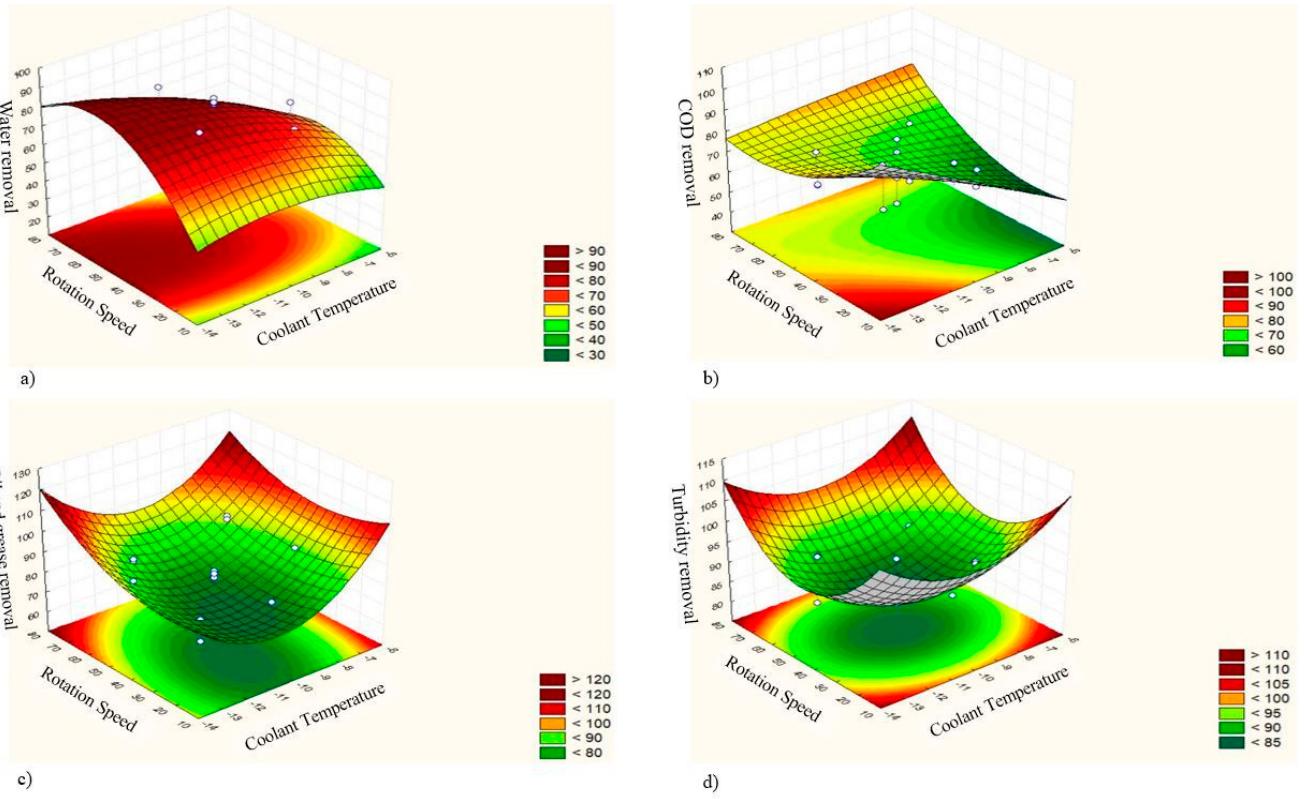
Figure 6. 3D surface plot of ( a ) water removal ( b ) COD removal ( c ) oil and grease removal ( d ) turbidity removal as a function of rotation speed and coolant temperature.